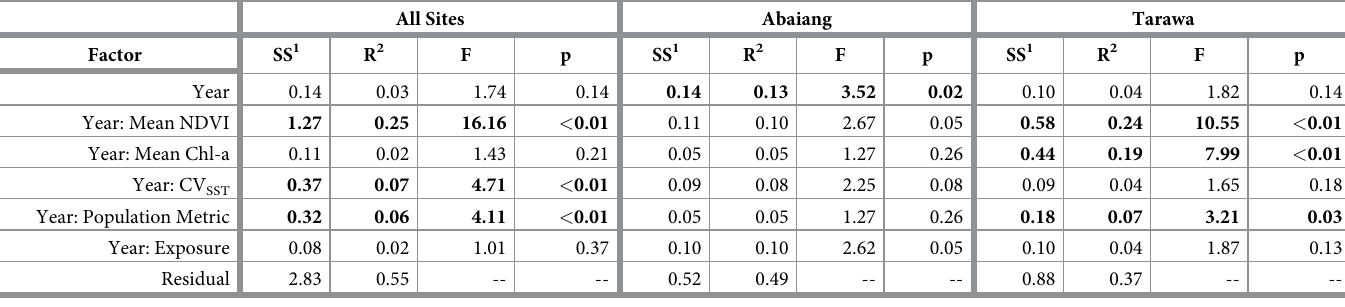
Table 6. PERMANOVA of predictors of benthic composition across sites. Statistically significant values are in bold. All Sites